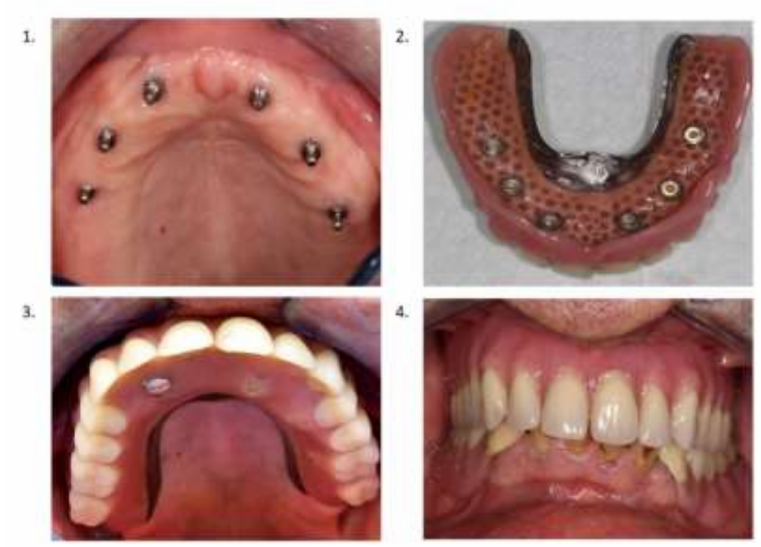
Figure 1. ( 1 ) MDI in atrophic maxillary jaw; ( 2 ) MDI overdenture mucosal side; ( 3 ) MDI overdenture in situ; ( 4 ) MDI overdenture in